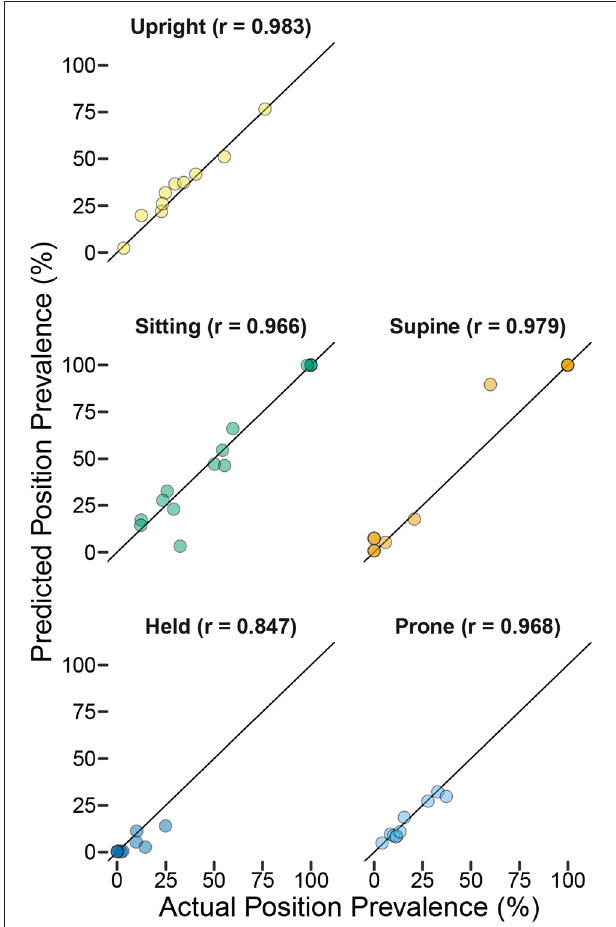
FIGURE 6 | Predicted position prevalence from classification ( y -axis) plotted against actual position prevalence from human coding of body position ( x -axis) for home case study Participant B. Each point represents the proportion of time the infant spent in each position during each of 17 7.5-min periods that were video recorded following the end of the training session (titles indicate the r -value for the correlation between actual and predicted within each position category). Note that several points are overlapping (e.g., the infant was supine and sitting 100% of the time for multiple periods and was held 0% of the time for multiple periods). The overall correlation between actual and predicted prevalence across positions/periods was r =